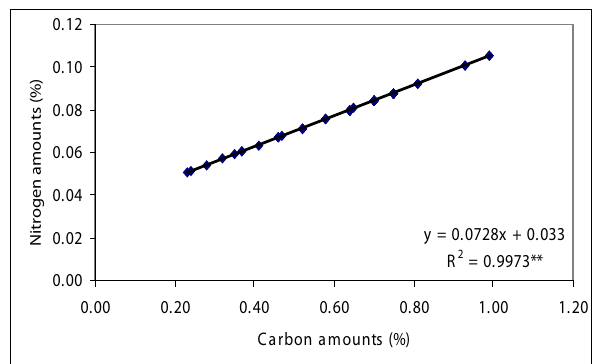
Fig. 2. Relationship between carbon and